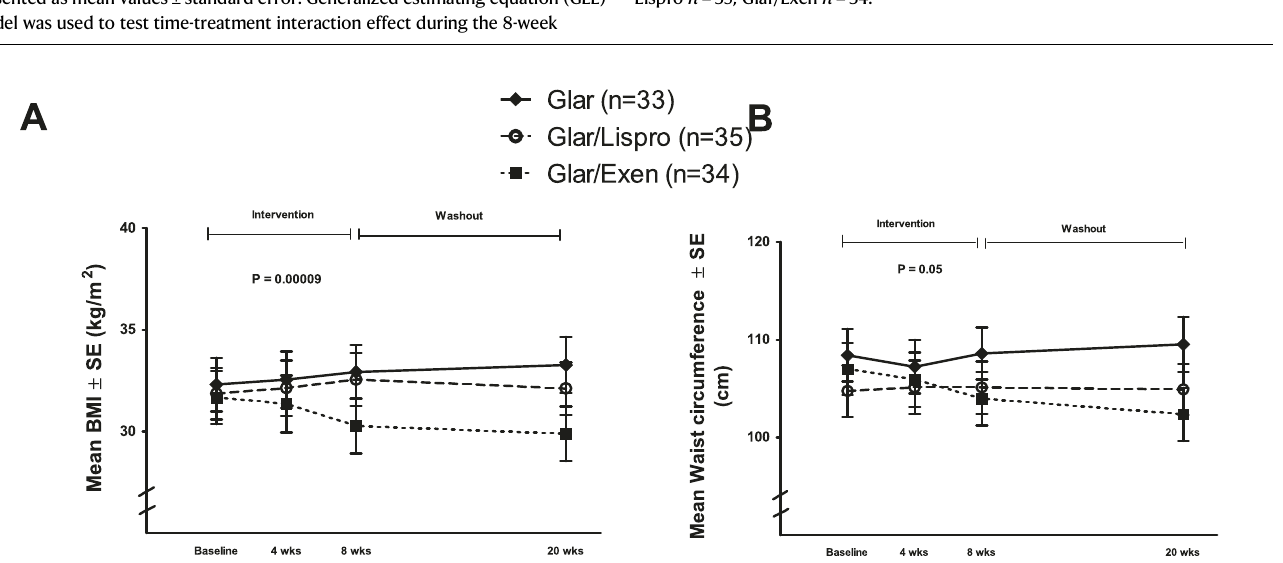
intervention. Two-tailed P -values<0.05 were considered statistically signi fi cant (multiple comparisons not considered). Number of participants: Glar n =33; Glar/ Lispro n =35; Glar/Exen n =34.